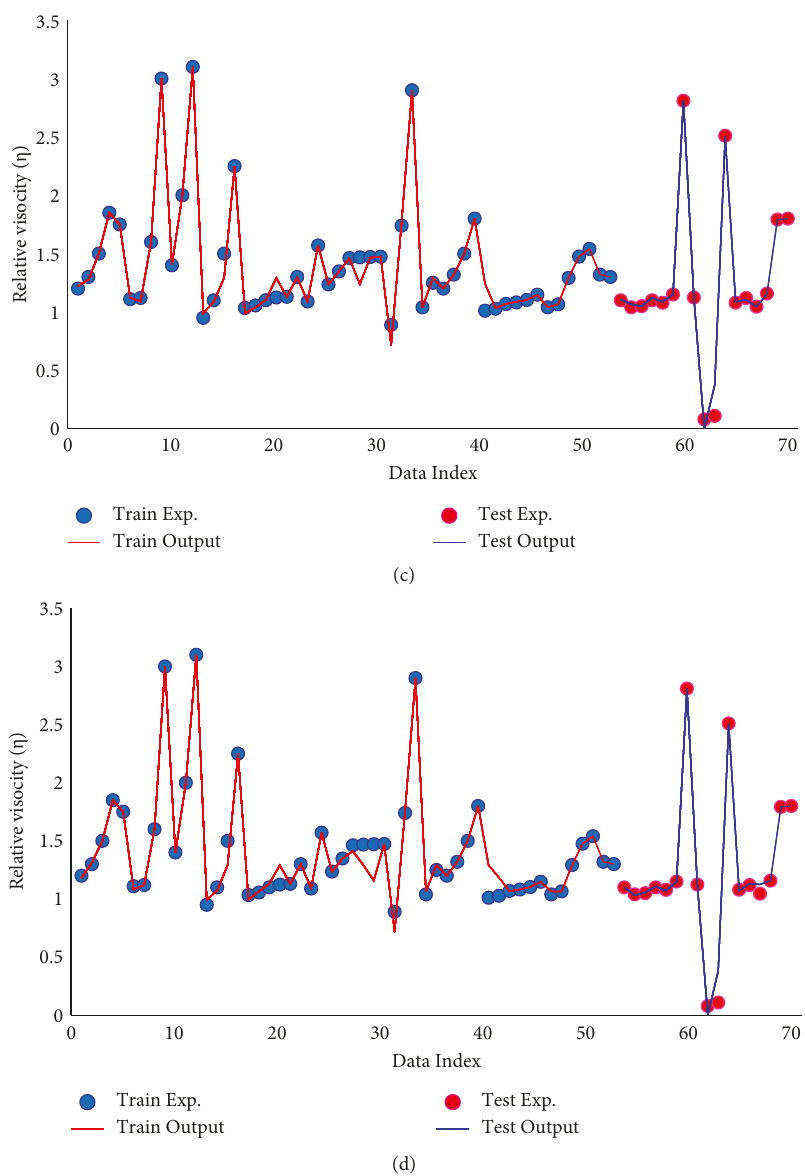
Figure 1: Simultaneous observation of modeled and real data to visually observe the accuracy of the model in different phases of modeling: (a) Matern, (b) exponential, (c) squared exponential, and (d) rational